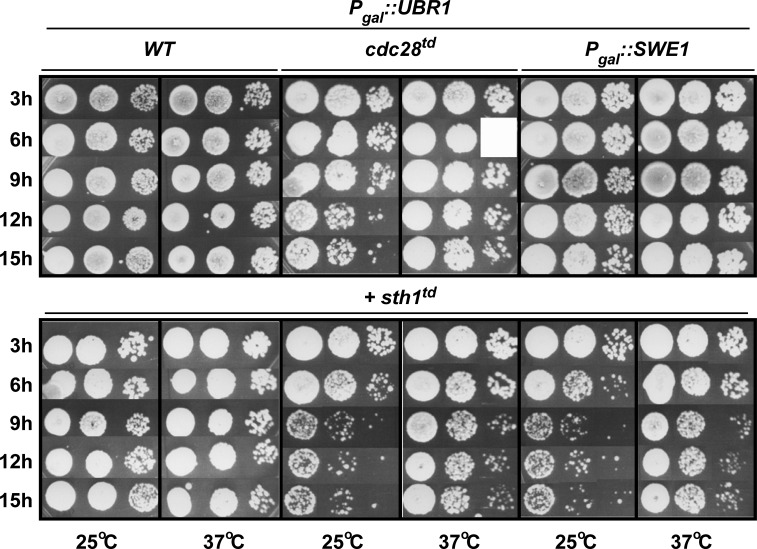
Synthetic Sickness Phenotype of sth1td, cdc28td, and sth1td, Pgal::SWE1 Double MutantsHaploid yeast strains harboring Pgal::UBR1 and combinations of sth1td and cdc28td (cdk1td) or Pgal::SWE1 were analyzed for their ability to form colonies after growth in galactose for the indicated times at the indicated temperatures, by seeding-out 10-fold serial dilutions of an equal number of cells onto solid glucose medium containing 0.1 mM CuSO4. Note the dramatically increased severity of the lethal phenotypes of cdc28td and Pgal::SWE1 alleles when they were combined with sth1td. The data shown are from one experiment and are representative of at least three independent experiments.